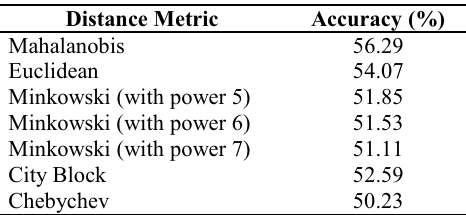
Table 6. Polynomial based distance metrics using convex hull